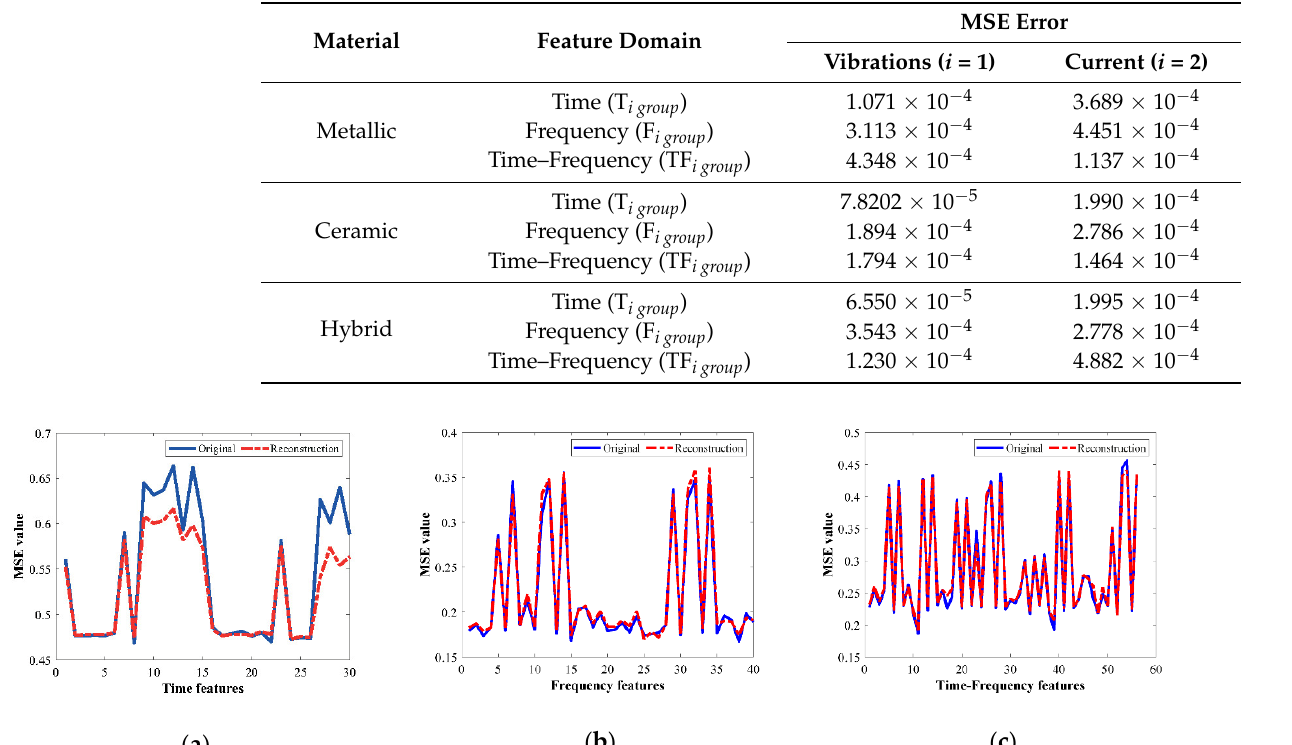
Table 6. MSE error achieved by the GA during the tunning and optimization of hyperparameters of the considered SAE structures for each domain of analysis, all technology materials.